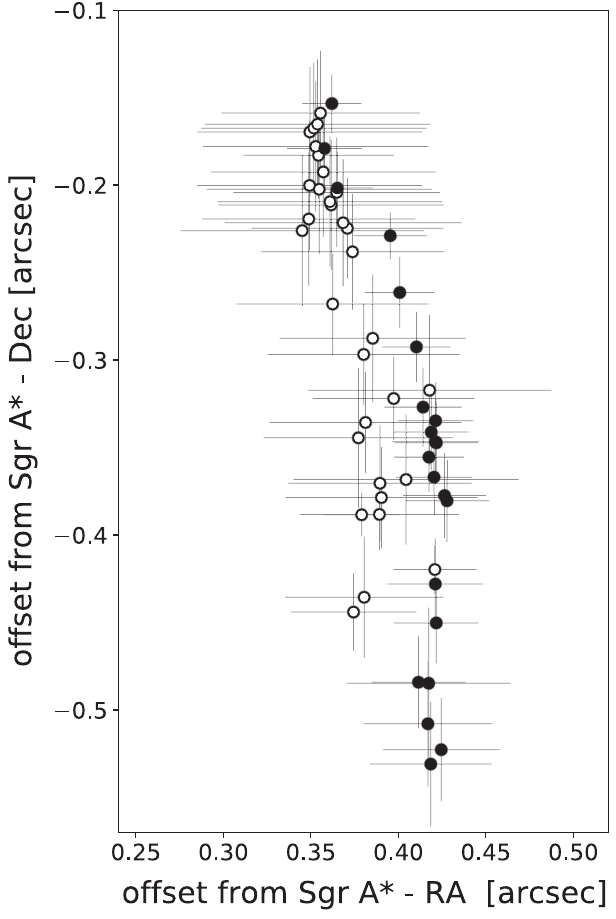
Figure 14. X7 astrometry as measured in OSIRIS ( white points ) and NIRC2 ( black points )